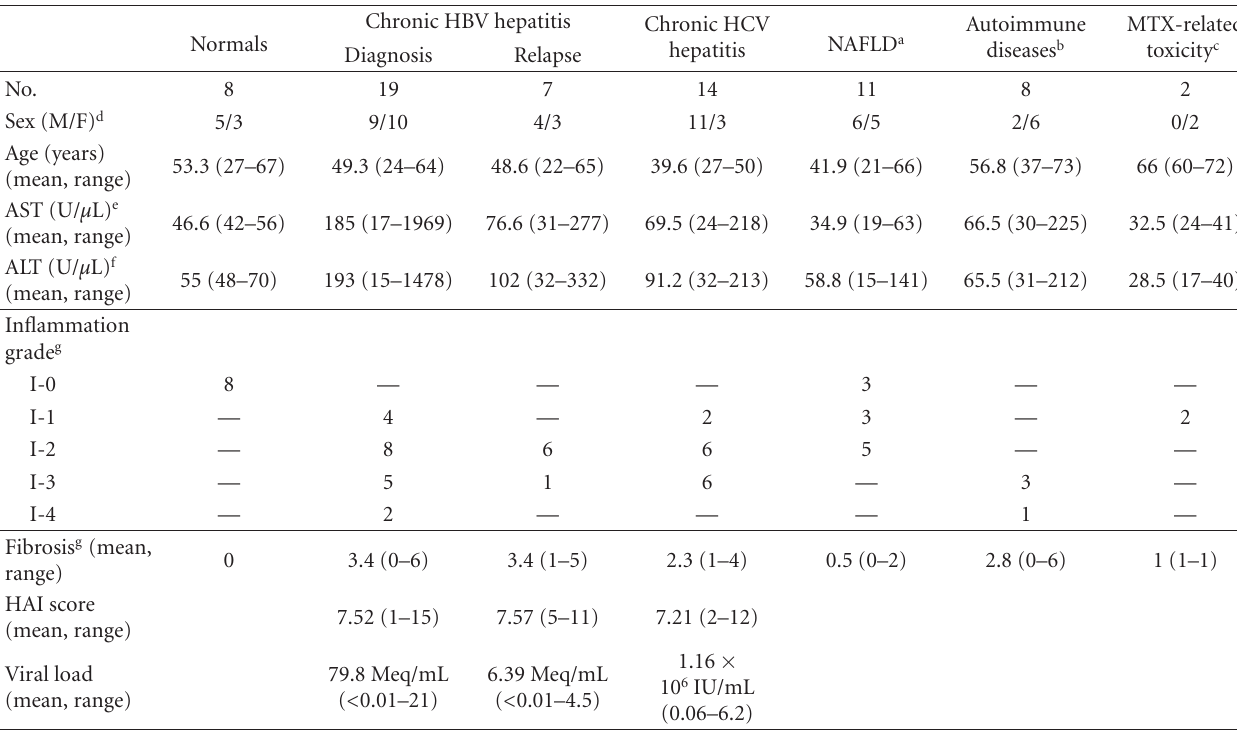
Table 1: Clinicopathological and serological data of the patients of the study.